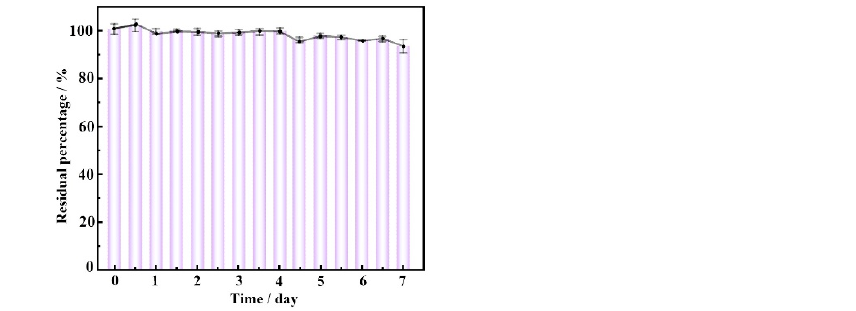
Figure 6. The change of DM insecticide residues on the glass one week post-dropping.